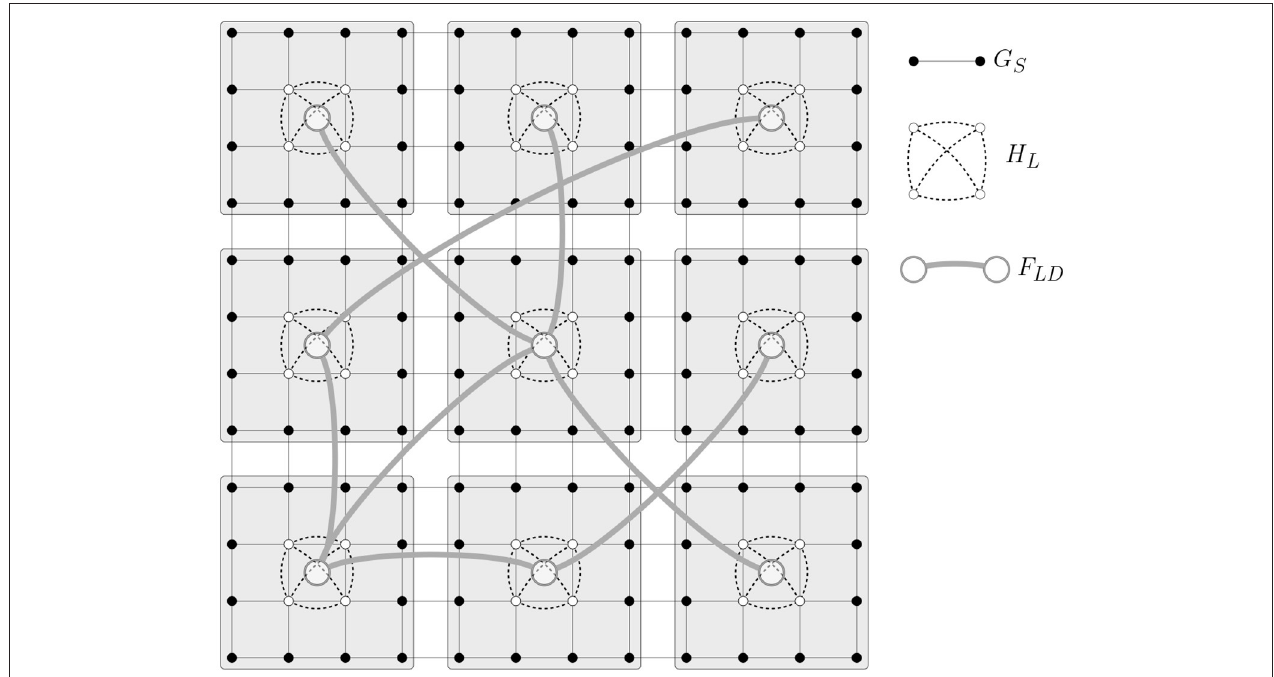
FIGURE 2 | An instance of the multi-pathway spatial network model MPSN( n , r , k , s , H L , F LD ). Here, number of nodes n size s 4. The range r 1 resulting in a grid graph for G S . Here, the intra-locality graph H L is a clique on four = =